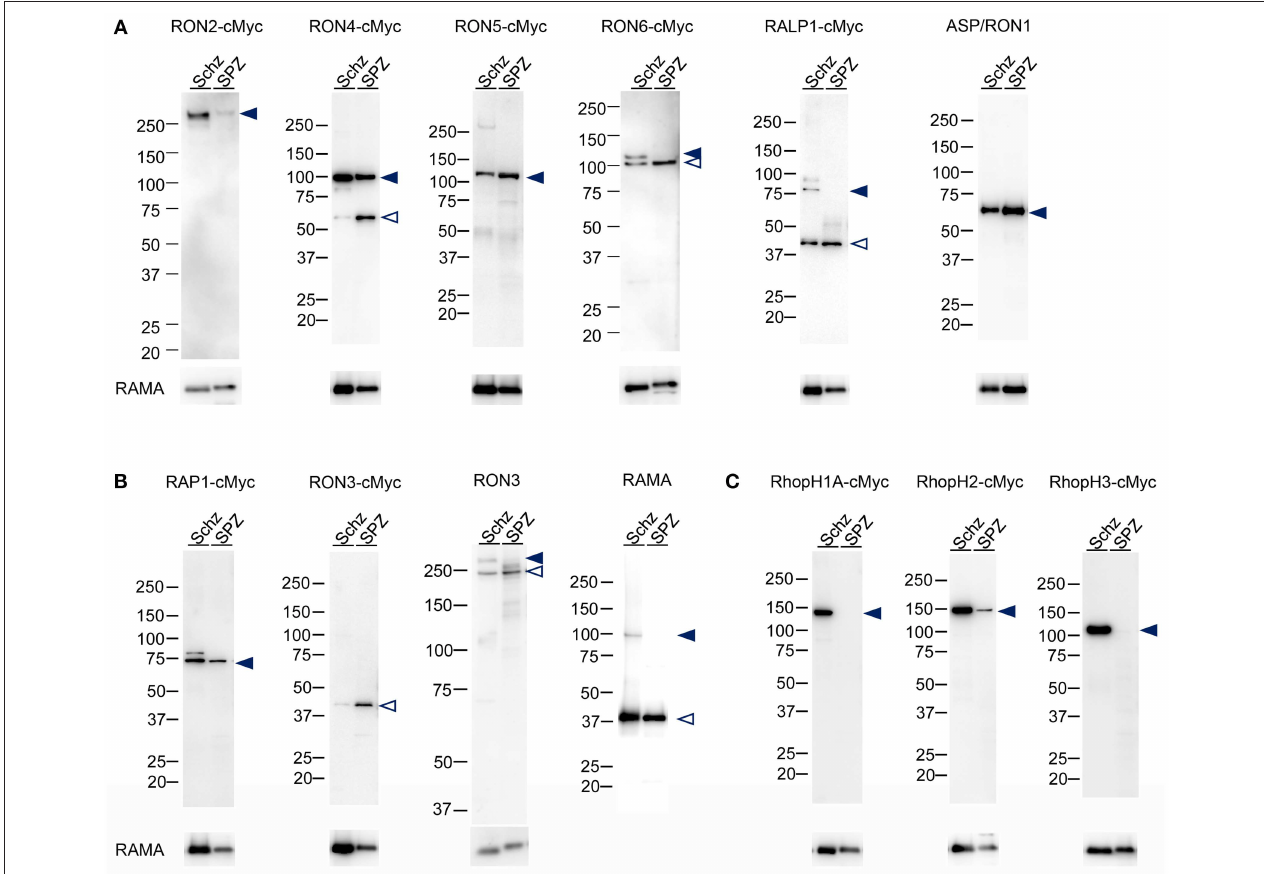
FIGURE 2 | Western blot analyses of rhoptry proteins in schizonts and sporozoites. Proteins were extracted from schizonts purified after in vitro culture of parasite infected erythrocytes (Schz) or sporozoites purified from midguts at days 24–26 post-feeding (SPZ). Each lane contains proteins from 1.5 × 10 5 schizonts or sporozoites of transgenic parasites expressing c-Myc tagged rhoptry proteins or WT-GFP. Target proteins were detected by western blotting using anti c-Myc antibodies or specific antibodies against ASP/RON1, RON3, or RAMA. The transgenic parasite lines used as antigens are indicated above panels; for example, RON2-cMyc. When specific antibodies were used to detect target molecules in WT-GFP parasites, the name of the target molecule is instead indicated. Closed- and open- arrowheads demonstrate the expected full-length and cleaved target proteins, respectively. The sizes of protein markers (kDa) are indicated on the left of each image. (A) Expression patterns of proteins categorized as rhoptry neck proteins in merozoites. ASP/RON1 was detected using rabbit specific antibodies as it contains a C-terminal GPI-anchor domain and is likely refractory to C-terminal c-Myc integration. (B) Expression patterns of proteins which are categorized as rhoptry bulb proteins in merozoites and transcribed in both merozoites and sporozoites. In the case of RON3, anti-c-Myc antibodies only recognized a roughly 40 kDa protein (RON3-cMyc), demonstrating that the C-terminal region was cleaved in both merozoites and sporozoites. Specific anti-RON3 antibodies detected full-length and cleaved forms of RON3 (RON3). (C) Expression patterns of proteins which are categorized as rhoptry bulb proteins in merozoites and predominantly transcribed in schizonts. Consistent with transcription analyses, the protein amounts of RhopH1A, RhopH2, and RhopH3 are far less in sporozoites than those in merozoites, indicated by closed